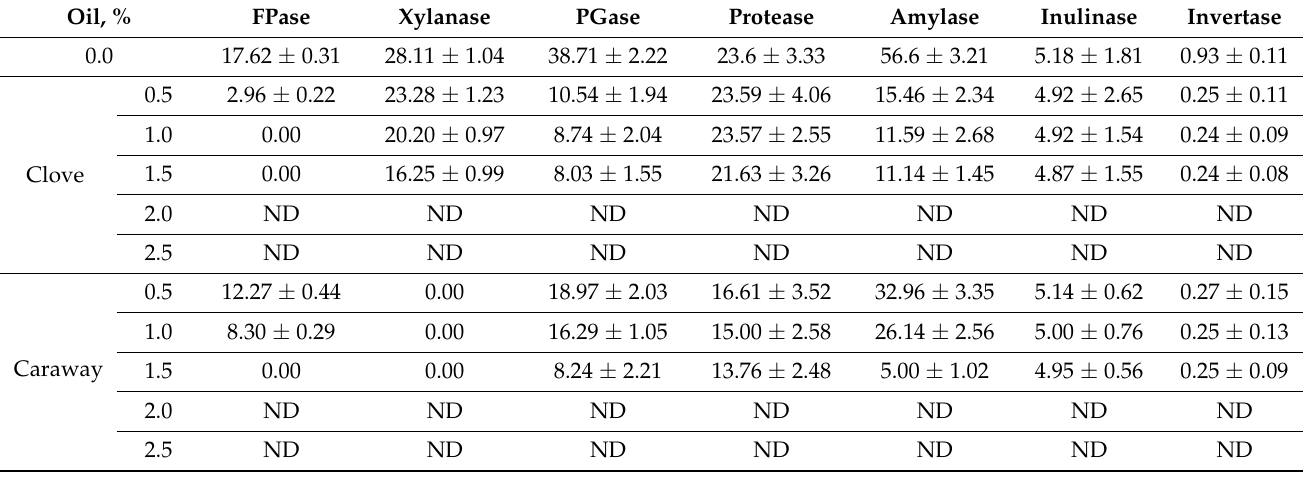
Table 2. Enzymatic profile of the pathogenic P. polonicum in the presence of various levels of the tested oils (U mean ± SD). Oil, % FPase Xylanase PGase Protease Amylase Inulinase Invertase 0.0